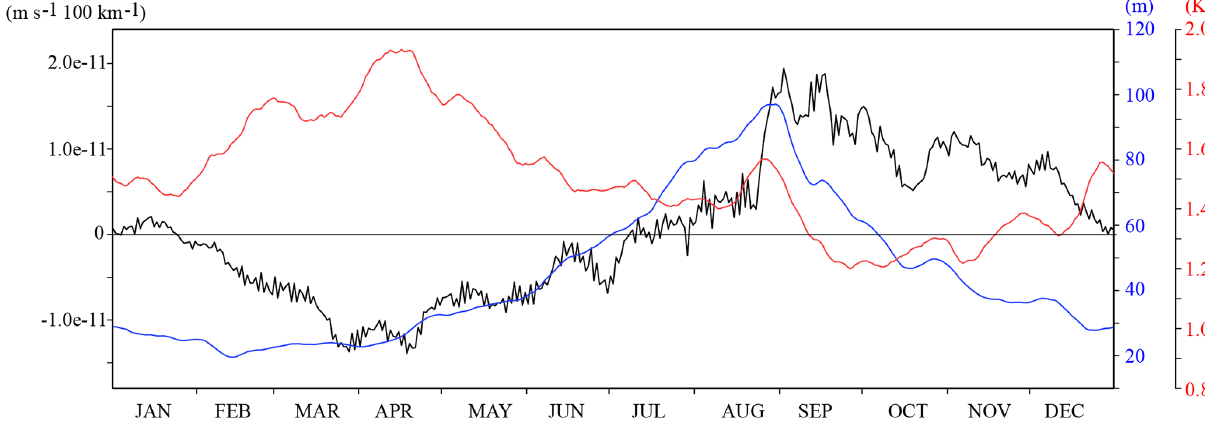
Figure 8. Time series of the area-averaged meridional gradient of the vertical velocity at the bottom of OML (black), OML depth (blue), intensity of upper-ocean thermocline stratification (red) over 17–15 ◦ S and 10–12 ◦ E. All variables are filtered by a moving 11-day